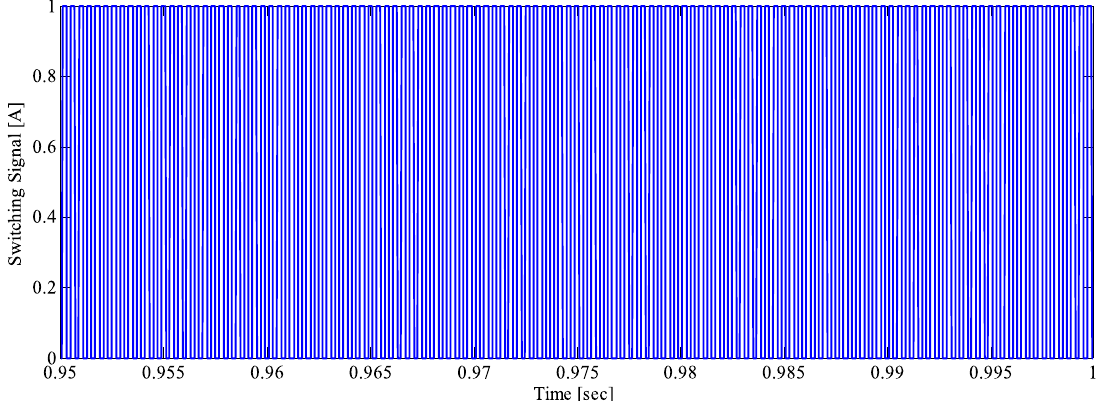
FIG. 12. SVPWM SWITCHING SIGNAL FOR VSI